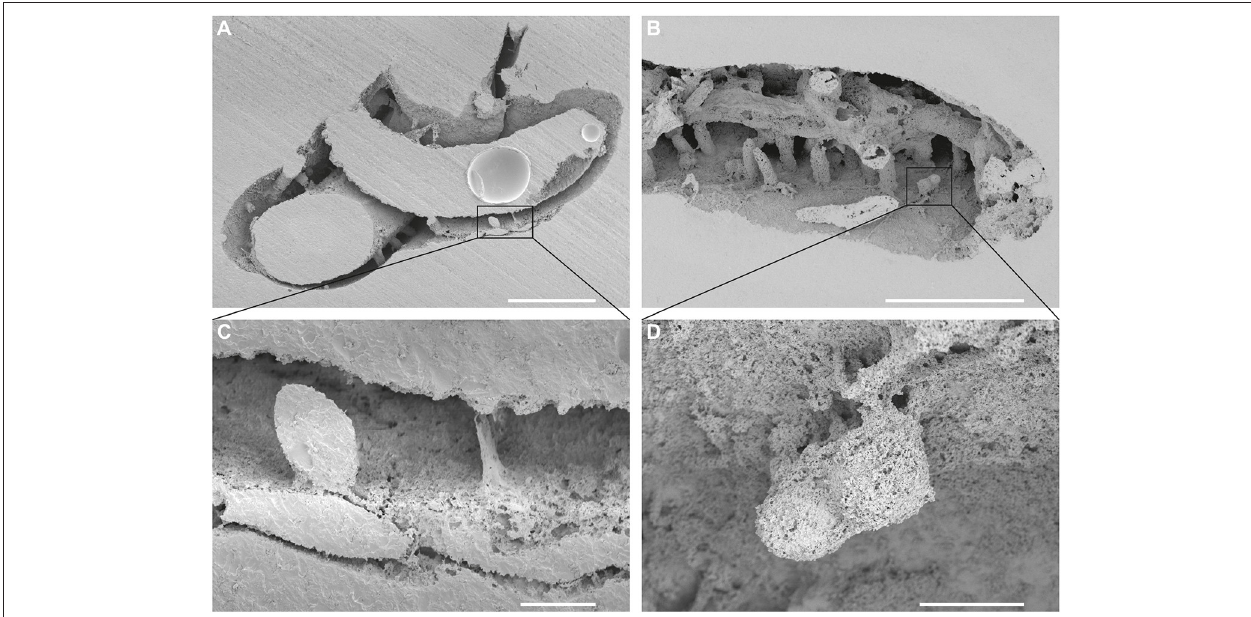
FIGURE 3 | Entobia isp. (A,C) A single-chamber specimen of Entobia isp. (in a square), from which a thin fiber protrudes from the bottom right and a short shaft at the bottom in the middle. The substrate is Cementula sp.; SEM images of casted CZ2; Velim, Bohemian Cretaceous Basin, Czechia. (B,D) A serpulid tube Pyrgopolon ( Septenaria ) cf. tricostata bored by Trypanites , Maeandropolydora, and two bi-camerate specimens of Entobia isp. (in a square). Note the very short and thin threads only on the one side of the chambers; SEM images of casted NM O8728; Kank “Na Vrších,” Bohemian Cretaceous Basin, Czechia. Scale bars = 1mm (A,B) , 100 µ m (C,D)